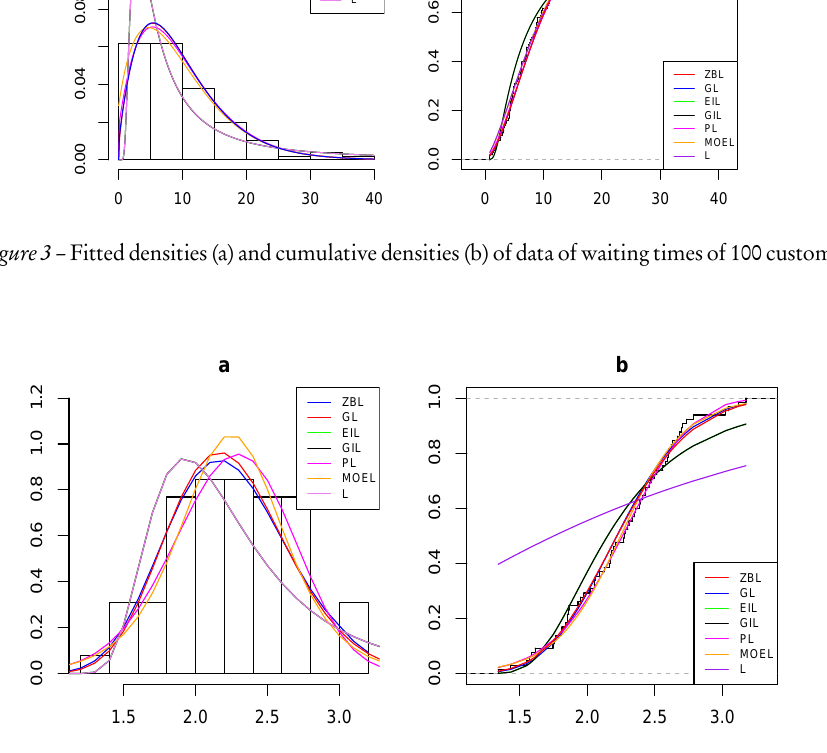
Figure 4 – Fitted densities (a) and cumulative densities (b) of data of the failure stresses of single carbon